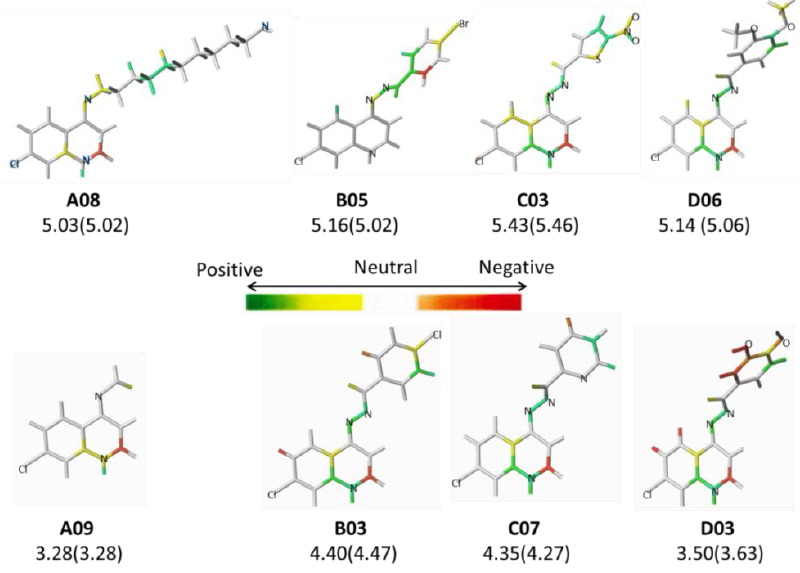
Figure 3. The HQSAR contribution maps of the most ( A08 , B05 , C03 , and D06 ) and least ( A09 , B03 , C07 , and D03 ) potent compounds according to the tautomer II model from each series ( A , B , C , and D ) along with the experimental (and calculated) pMIC values.